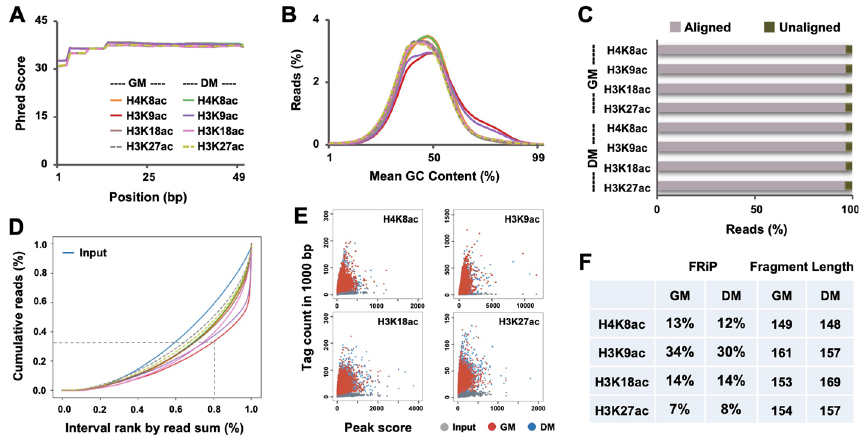
Fig. 3 Quality control of the ChIP-seq datasets. A The distribution of base quality scores for ChIP-seq of the indicated histone acetylation marks in C2C12 myoblasts differentiated for 24 h (DM) with proliferating myoblasts as control (GM). B The average GC content of the read signals. C The percentage of reads mapped to the reference genome for each of the histone acetylation marks. D Fingerprint plot presents the cumulative percentage of total reads found in a given percentage of the mappable reference genome. E Scatter plots of ChIP-seq. enrichments. F Shown are the FRiP scores determined by MACS2 and the